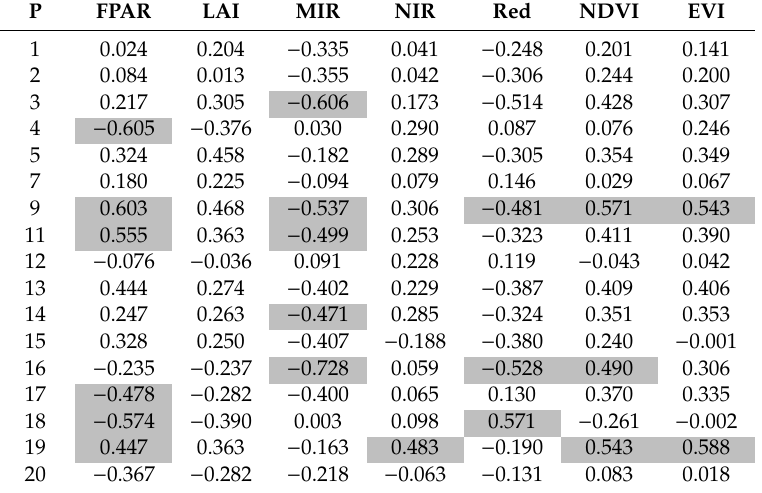
Table 2. Pearson correlation coe ffi cient between median height and composite MODIS satellite variables for every analyzed paddock (P). Significant ( p < 0.05) correlation coe ffi cient values are highlighted in grey. FPAR: Fraction of photosynthetically active radiation, LAI: Leaf area index, MIR: Middle infrared band, NIR: Near infrared band, Red: Red band, NDVI: Normalized di ff erence vegetation index, EVI: Enhanced vegetation index. P FPAR P FPAR LAI